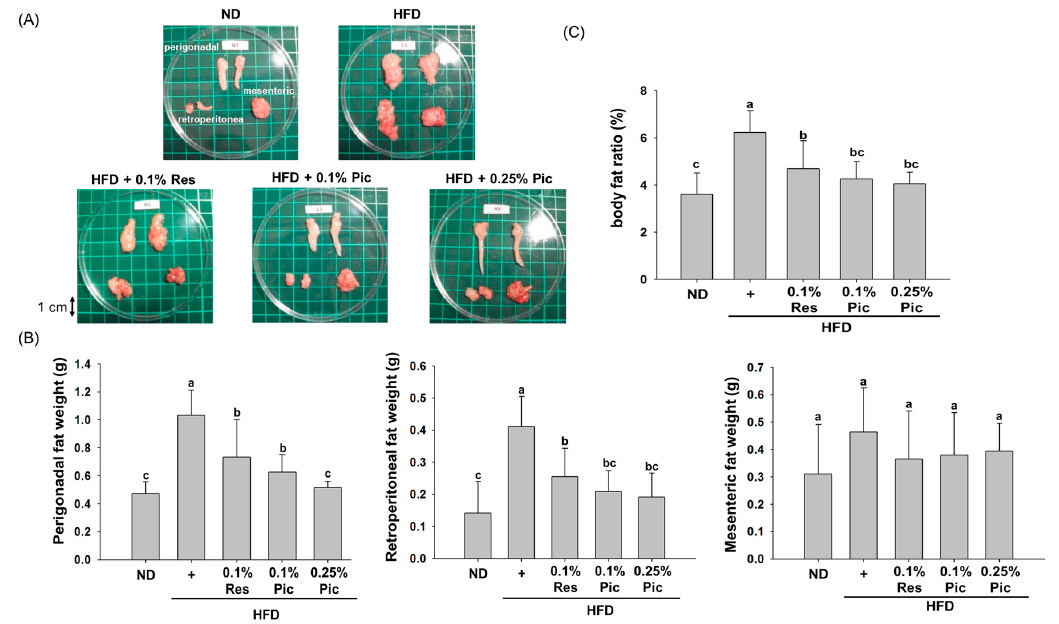
Figure 2. Effect of piceatannol supplementation on adipose tissue weight in HFD-fed C57BL/6 mice. ( A ) Representative images of fat pads from each group; ( B ) The weight of perigonadal, retroperitoneal and mesenteric adipose tissues; ( C ) Body fat ratio, which was calculated using the following formula: adipose tissue weight (perigonadal + retroperitoneal + mesenteric fat weight)/body weight × 100 (%). Data are expressed as the means ± SE ( n = 8 per group). The values with different letters are significantly different ( p < 0.05) as determined by Duncan’s multiple range test.